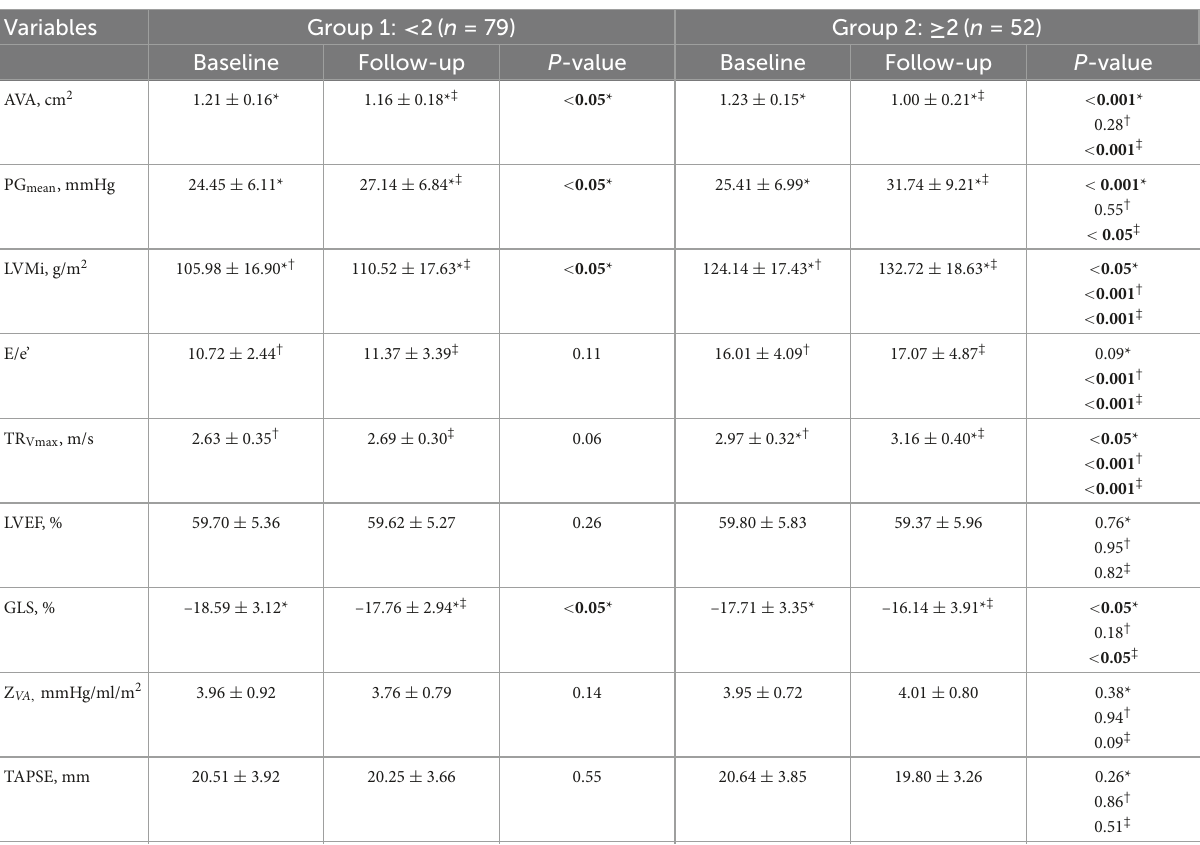
TABLE 2 Echocardiographic results of patients with moderate aortic valve stenosis (AS).